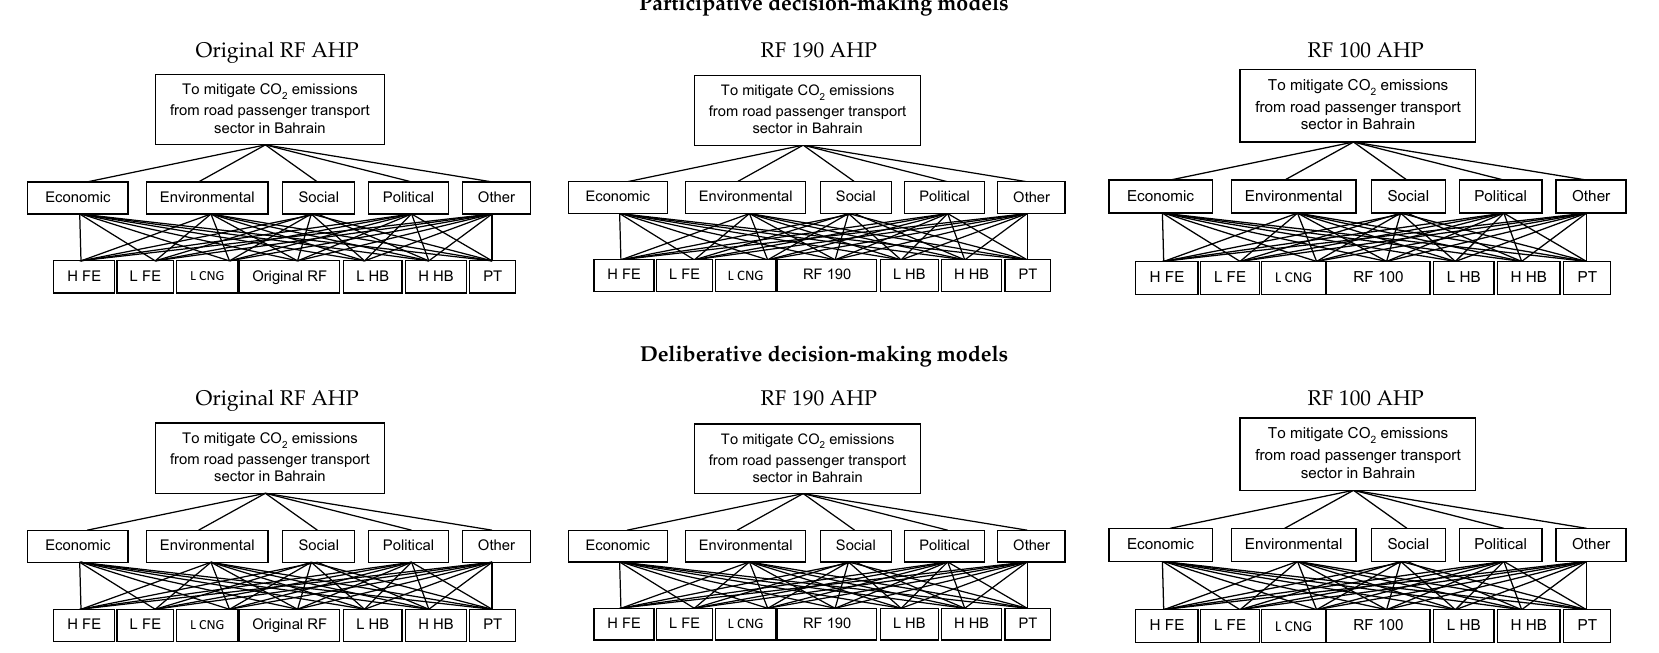
Figure 3 . The design of the participative and deliberative decision-making models. Figure 3. The design of the participative and deliberative decision-making